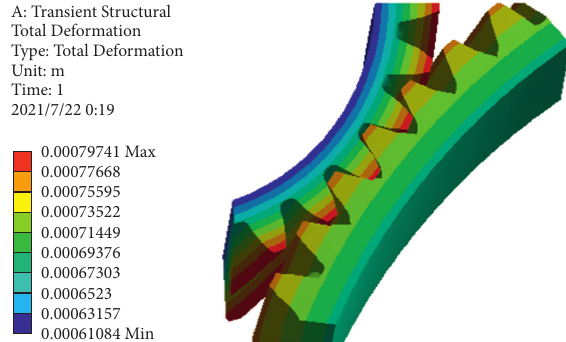
Figure 18: Deformation nephogram of helical gear set.